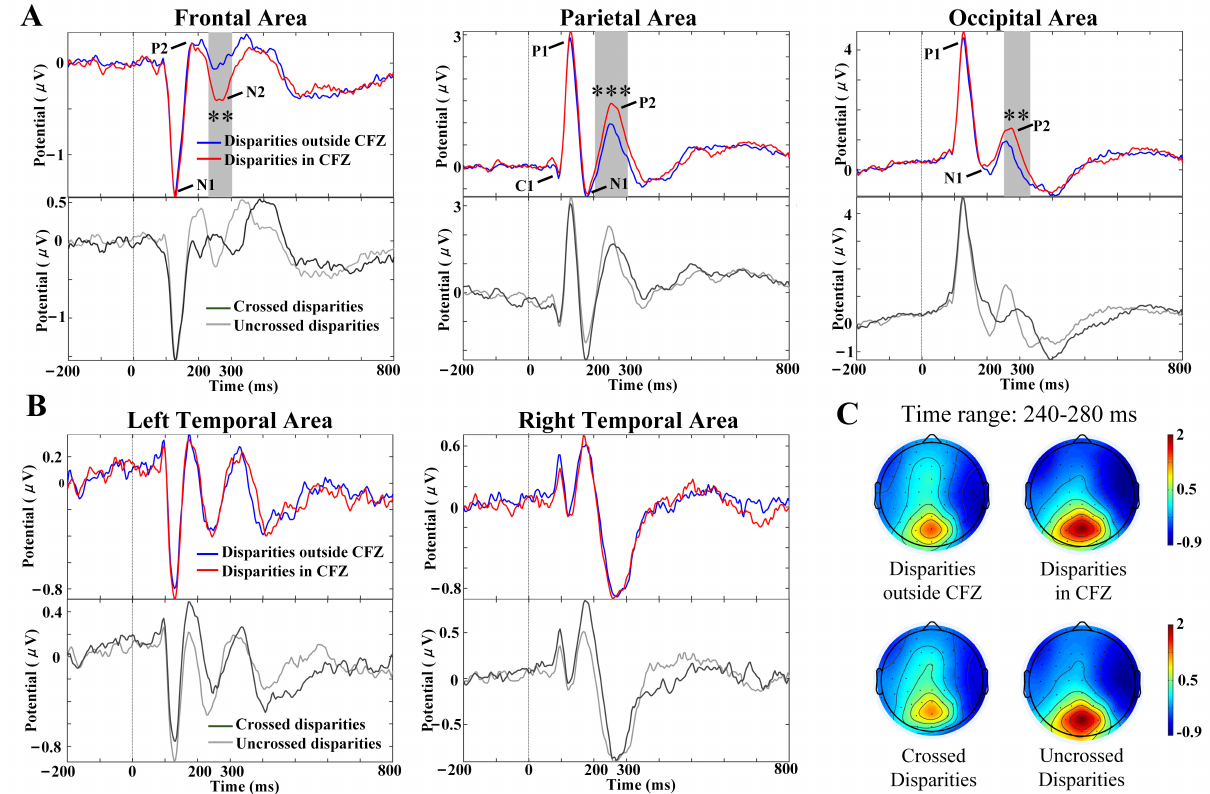
Figure 4. Effects of different disparities on VEPs components. ( A ) VEPs corresponding heat map and waveform images at frontal, parietal and occipital areas for crossed disparities versus uncrossed disparities, and disparities in CFZ versus disparities outside CFZ. ( B ) VEPs corresponding heat map and waveform images at left and right temporal areas for different disparities. ( C ) The topographical varieties of components P2 (time range: 240–280 ms) in the 2 disparity groups. The grey under- lining denotes time region of amplitude significant differences after the cluster method corrected, *** p < 0.001, ** p <